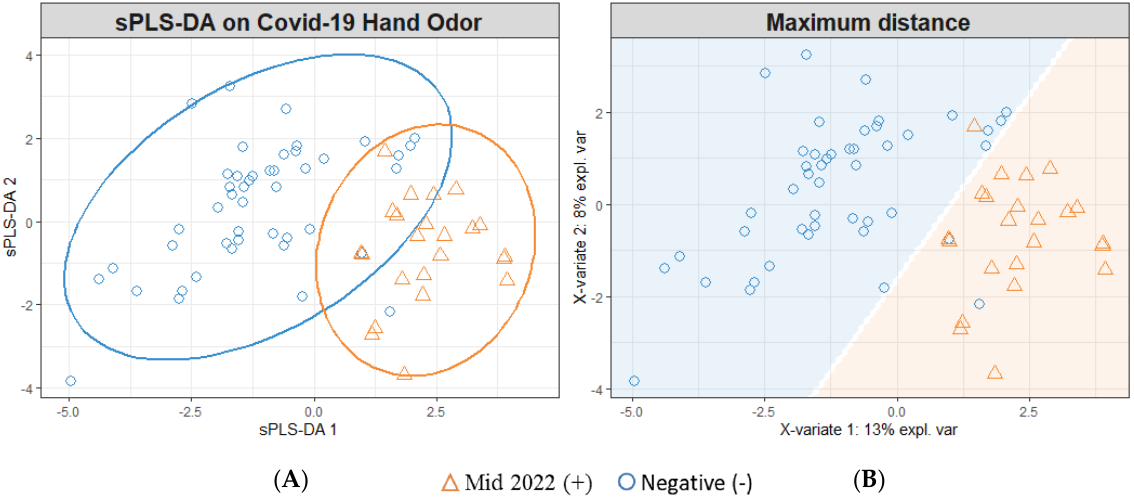
Figure 4. Mid-2022 sPLS-DA Model; (+) Mid-2022 Hand Odor Samples vs. ( − ) SARS-CoV-2 Samples. ( A ) Individual sample plot; ellipses = 95% CI. ( B ) Individual sample plot; background delineates class assignment.